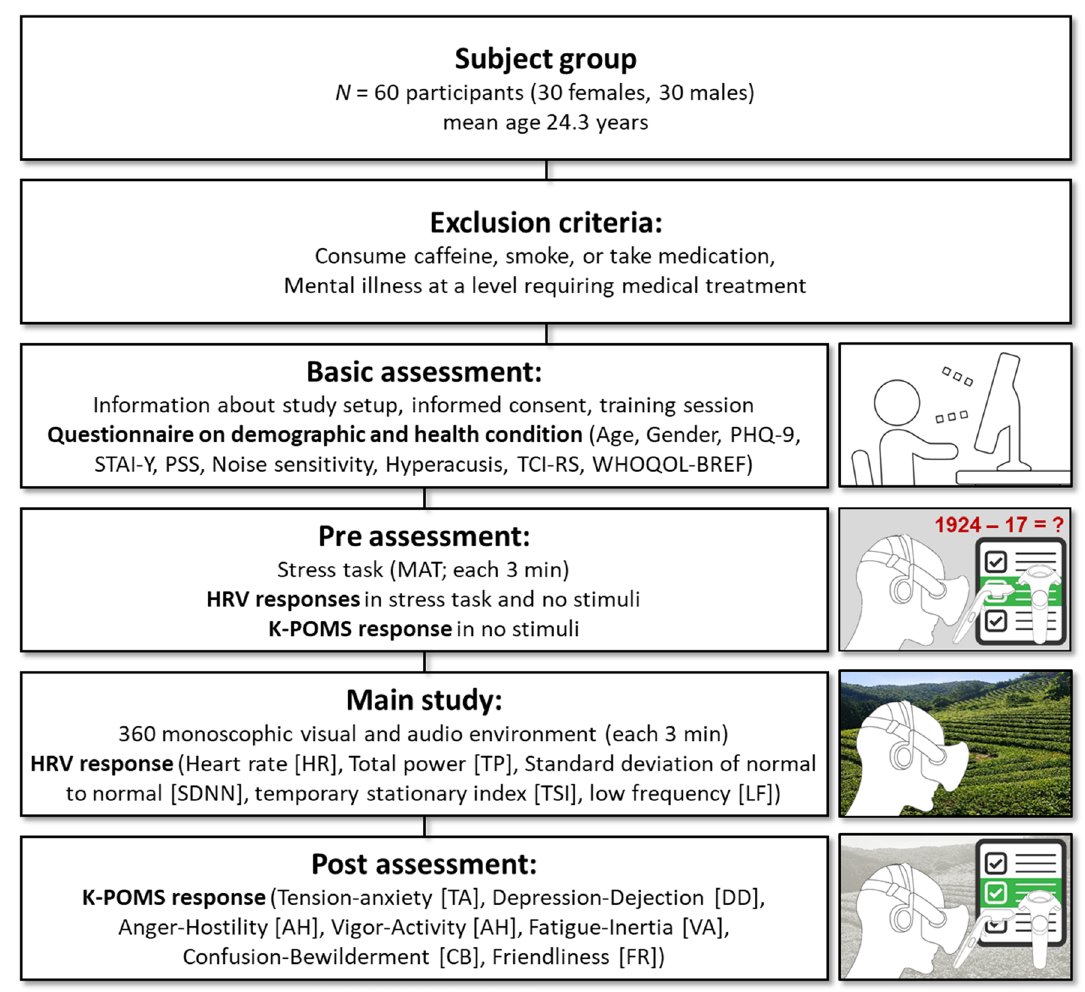
Figure 2. Study procedure. Patient Health Questionnaire (PHQ-9), State-trait Anxiety Inventory (STAI-Y), Perceived Stress Scale (PSS), Temperament and Character Inventory-Revised Short Version (TCI-RS), World Health Organization Quality of Life Questionnaire (WHOQOL-BREF), Mental Arithmetic Tasks (MAT), Heart Rate Variability (HRV), Korean edition of Profile of Mood States